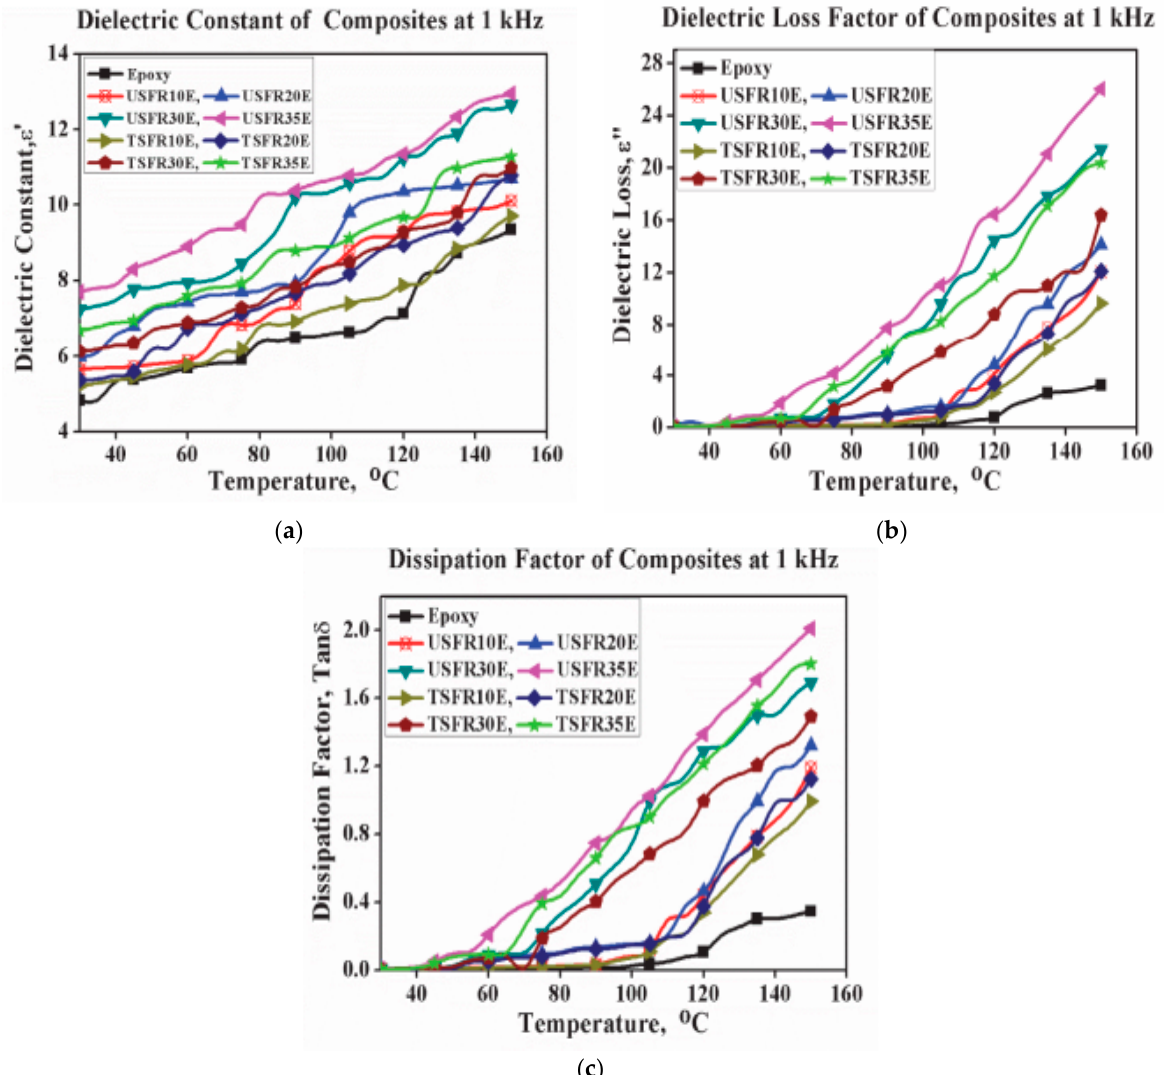
Figure 5. Electrical properties: ( a ) Dielectric constant, ( b ) dielectric loss, and ( c ) dissipation factor of untreated and treated sisal fiber-reinforced epoxy composites [142] (Reprinted/adapted with permission from IEEE Ref. 18162007 Copyright 2018).